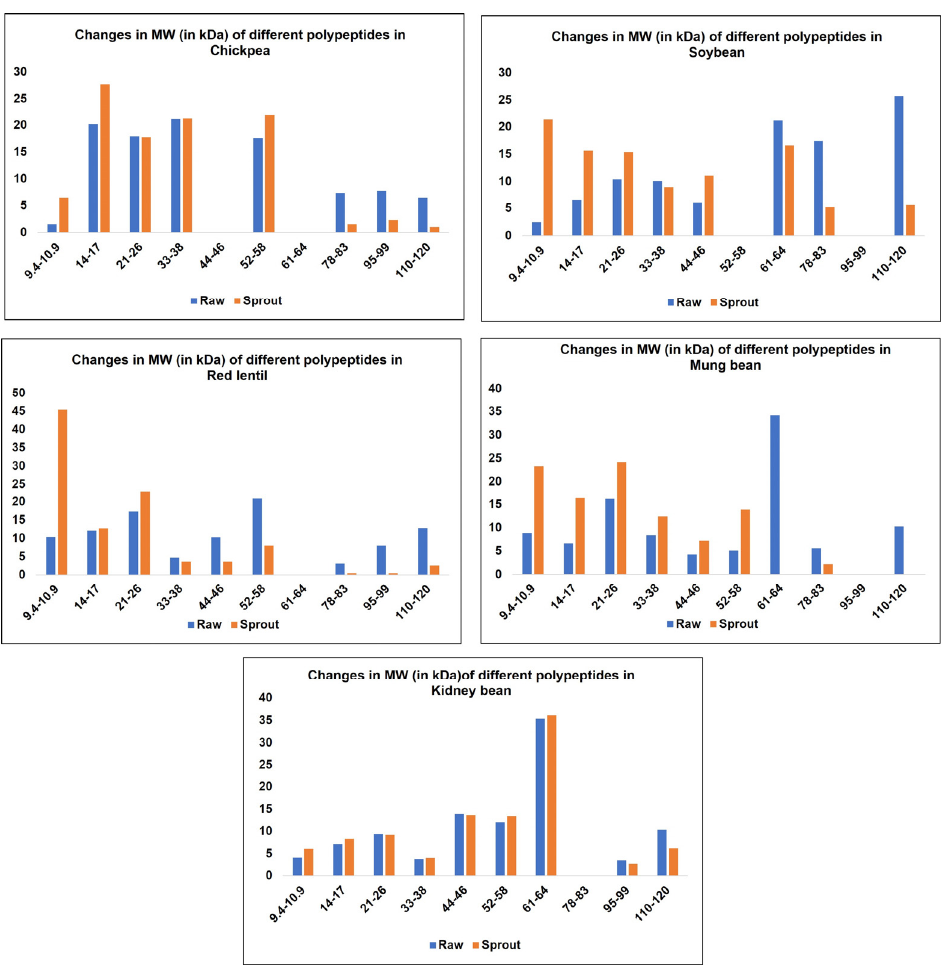
Figure 1. Changes in molecular weight of different polypeptides after germination at 40 °C in various legumes (% of total protein) (adapted with permission from Mammila et al, Effect of germination on antioxidant and ACE inhibitory activities of legumes; published by Elsevier, 2017) [49].